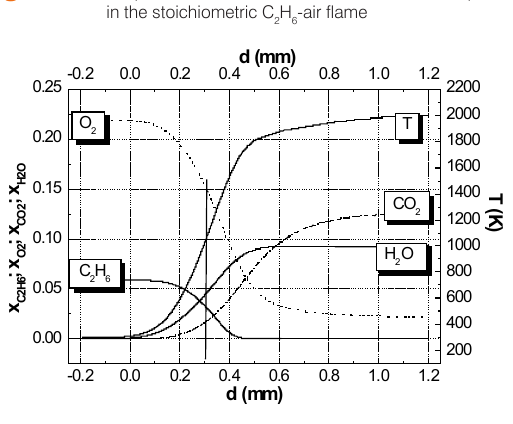
H -air flame 2 6